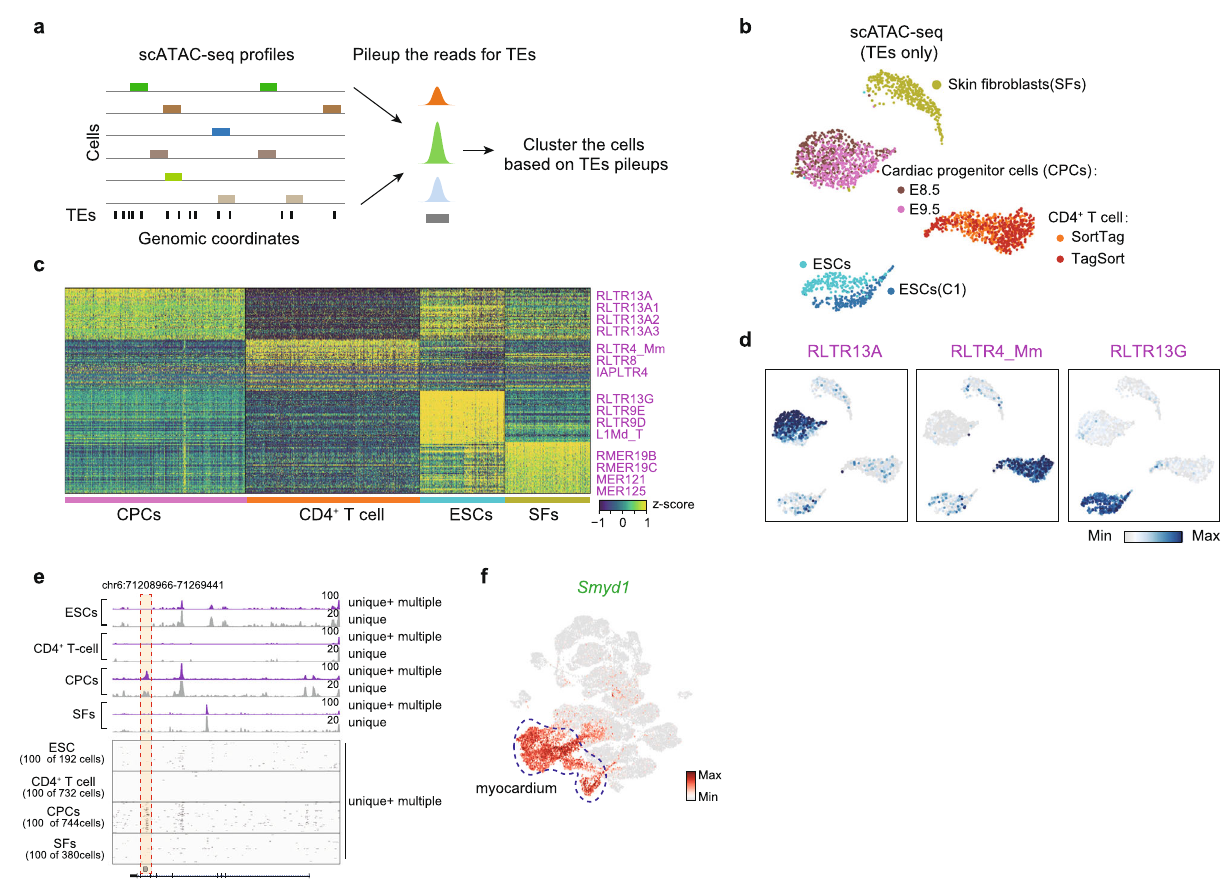
Fig. 6 Analysis of the chromatin state of TEs in single-cell ATAC-seq data. a Schematic plot of scTE for scATAC-seq data analysis. The reads are mapped to the genome, and assigned to a metagene TE, and then the cells were clustered based on the TE matrix. b UMAP plot of the TE chromatin state from scATAC-seq data for a selection of FACS-puri fi ed mouse cell types. c Heatmap of the top 50 cell type-speci fi c opened TEs in the indicated cell types, selected example TEs are indicated. d UMAP plot as in ( b ), but cells are colored by chromatin-state of the indicated TEs. e Genome tracks showing the aggregate scATAC-seq pro fi les (top panel). Randomly selected 100 single cell pro fi les are show below the aggregated pro fi les (bottom panel). Which include (unique + multiple), or exclude (unique), multiple mapped reads. f UMAP plot of the expression of the myocardium marker gene Smyd1 , from the cardiogenesis data, see Fig.